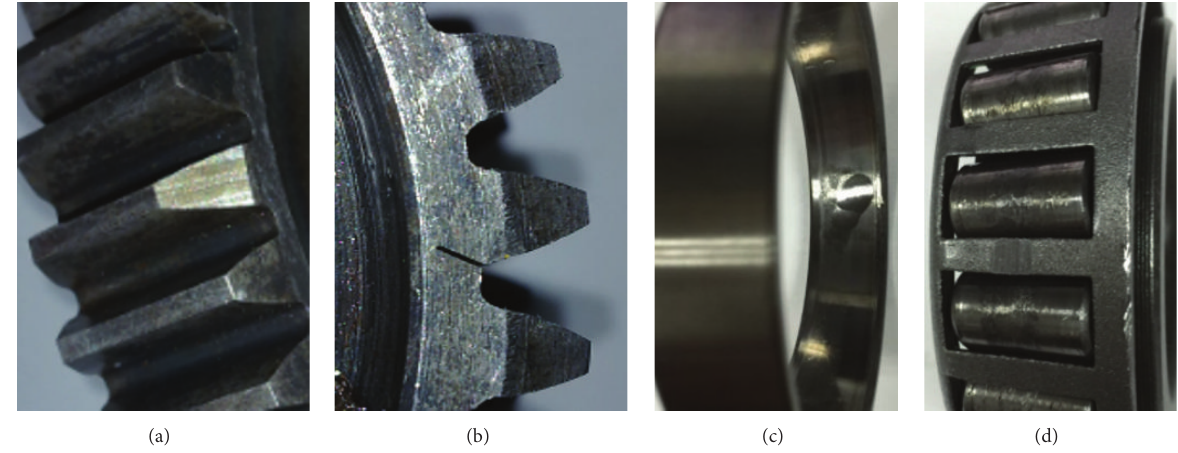
Figure 4: Chipped tooth (a), gear crack (b), bearing outer race wear (c), and bearing balls wear